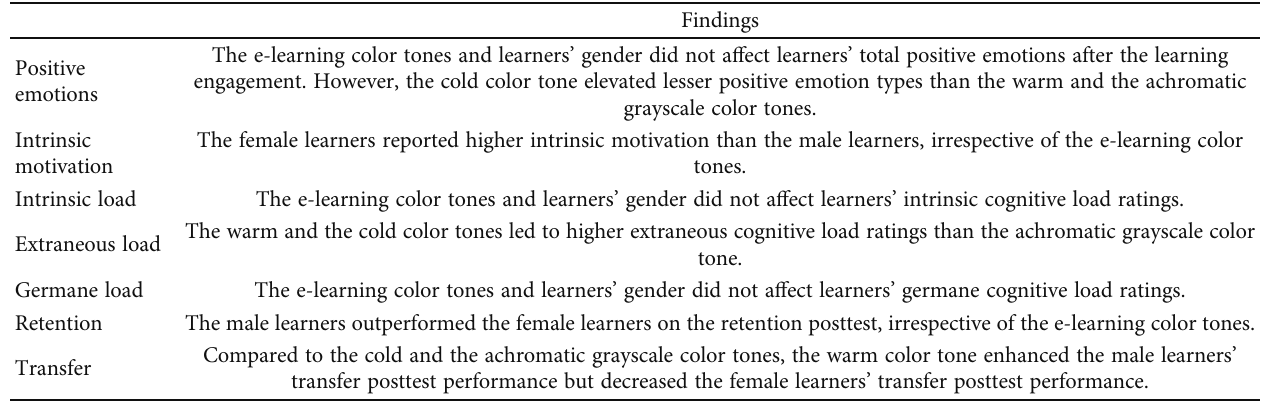
Table 3: Summary of fi ndings for each measure.